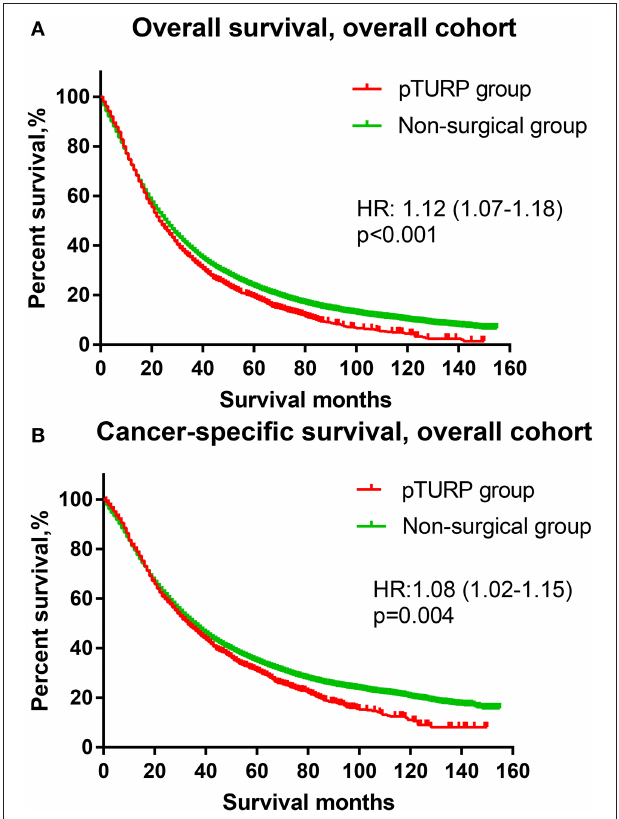
FIGURE 1 | The overall survival (OS) and cancer-specific survival (CSS) curves of the transurethral resection of the prostate (TURP) and non-surgical group for patients with metastatic prostate cancer (mPCa) in the overall cohort. (A) OS curve. (B) CSS curve.